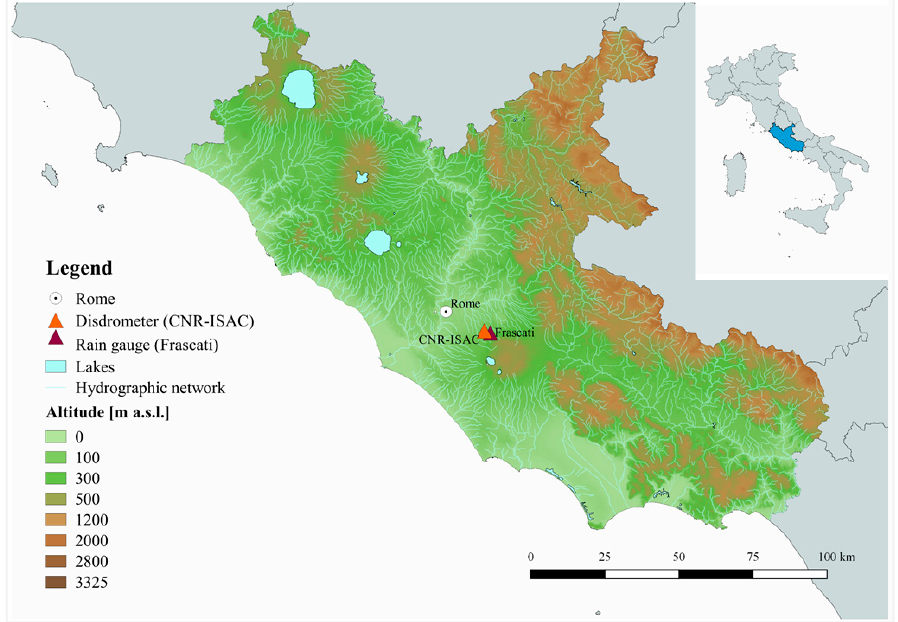
Figure 1. Locations of the case study area in the Lazio region (central Italy), the OTT Parsivel 2 disdrometer installed in Rome (ISAC-CNR), and the rain gauge used for analysis.